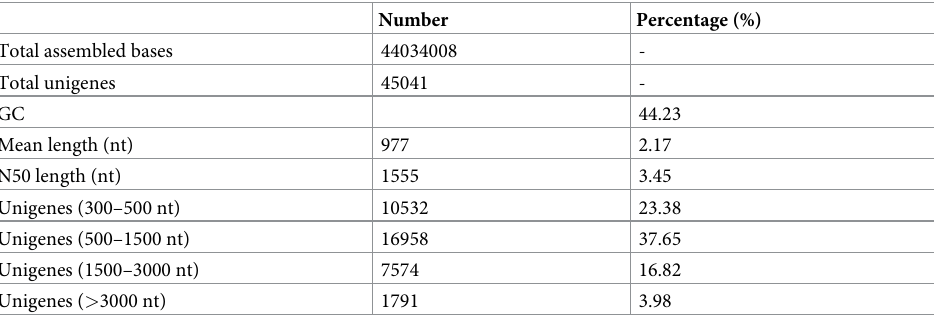
Table 2. Summary of the de novo